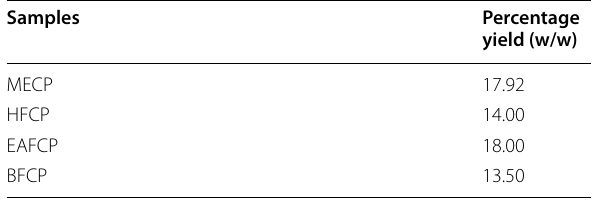
Table 1 Percentage yield of methanol extract and fractions of C. paniculatum